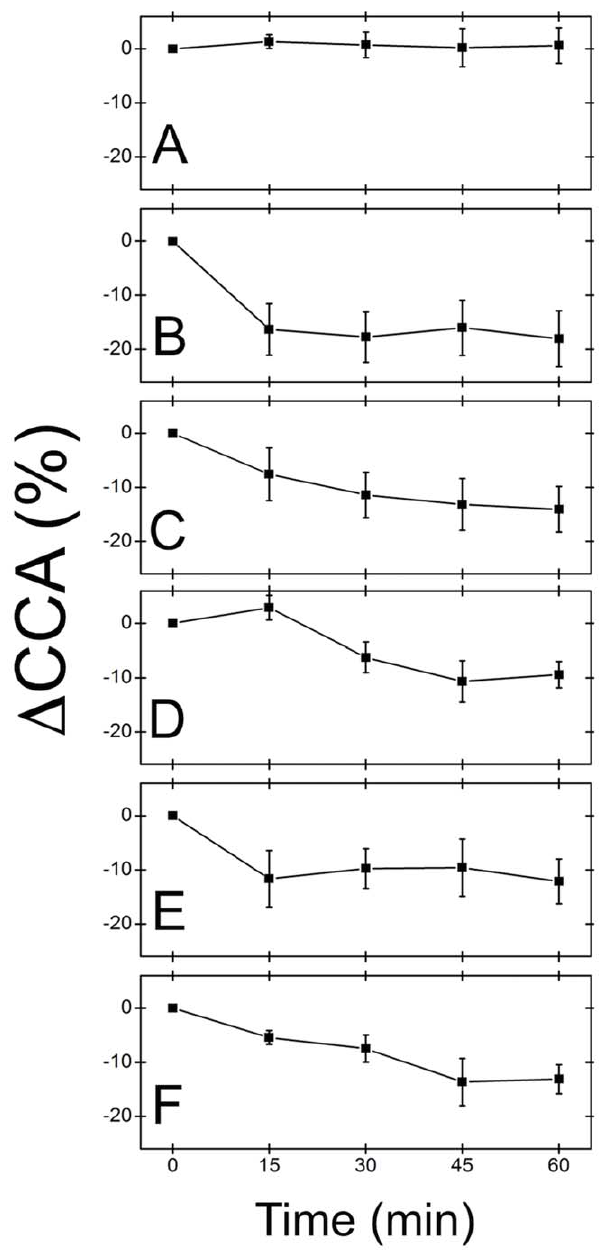
Figure 4. Dynamic changes in C2C12 close contact area over 60 mins. Cells were treated with various inhibitors and IRM images were acquired every 15 mins for 60 mins. ( A ) Control, ( B ) Cyt-D, ( C ) nocodazole, ( D ) Y-27632A, ( E ) ML-7 and ( F ) blebbistatin treated cells (n=3 cells for each condition). In each case, except for the control, a significant decrease in contact area occurs after 60 mins of exposure to each inhibitor. However, there was no statistically significant depen- dence on the type of inhibitor used. On average, the D CCA was , 13% for each condition, except for the control.